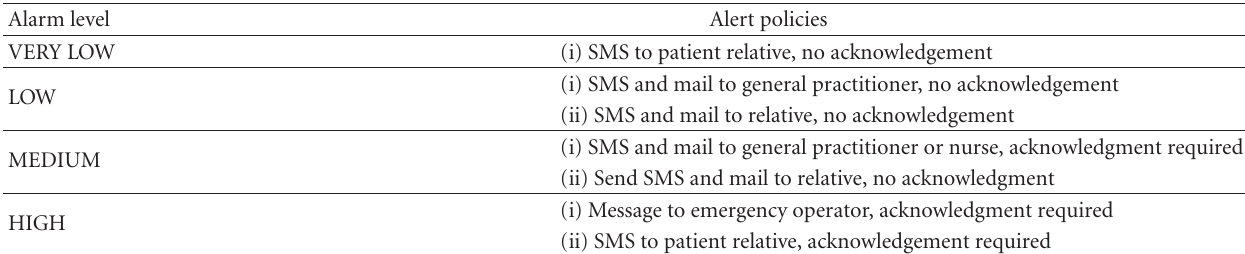
Table 1: Alert policy